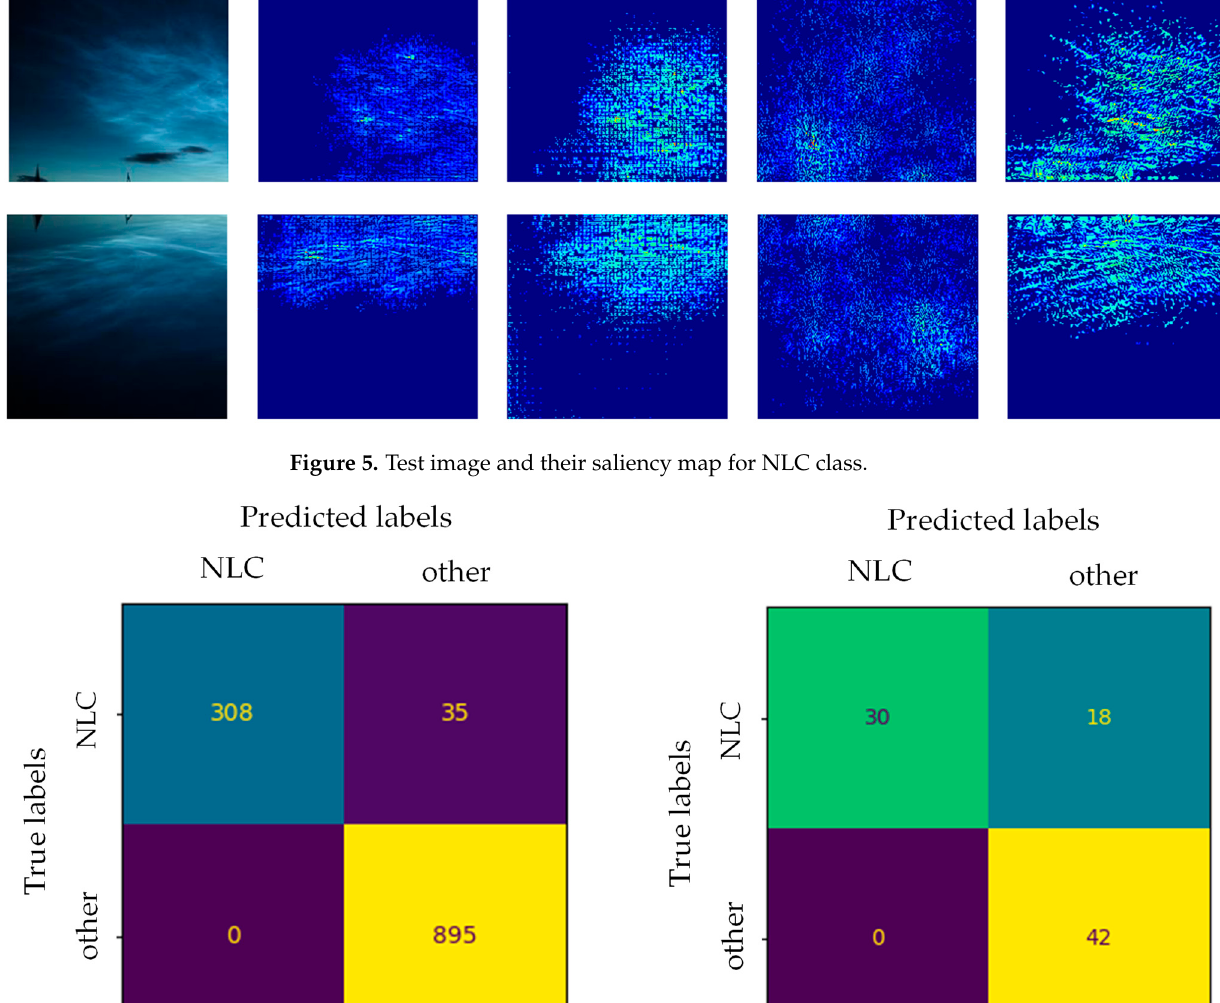
Figure 4. Test images and their saliency map for NLC class.